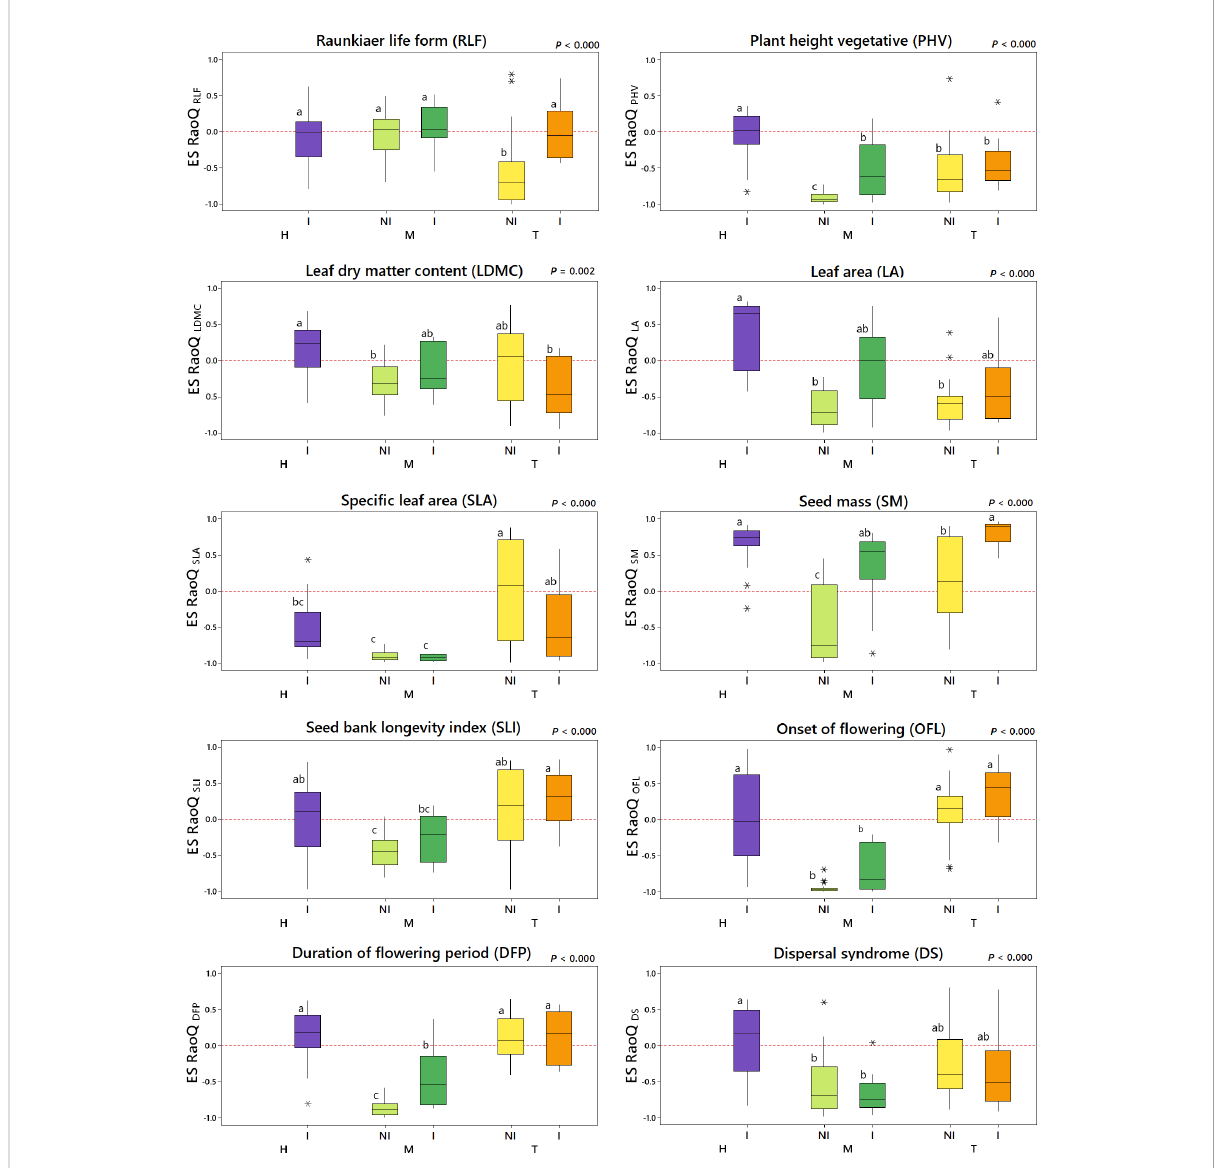
FIGURE 3 Effect size of RaoQ (ES RaoQ) for each single trait depending on the interaction of weed management and irrigation (WM:I). H, herbicide; M, mowing; T, tillage; NI, non-irrigation; I, irrigation. For pairwise comparison, a Student ’ s t-test was conducted, with P -values adjusted using the Bonferroni correction. Same letters on the boxes indicate no signi fi cant differences. Trait code indicated in the subscripts: RLF, Raunkiær Life Form; PHV, plant height; LDMC, leaf dry matter content; LA, leaf area; SLA, speci fi c leaf area; SM, seed mass; SLI, seed bank longevity index; OFL, onset of fl owering; DFP, duration of fl owering period; DS, dispersal syndrome. Outliers are indicated with an asterisk